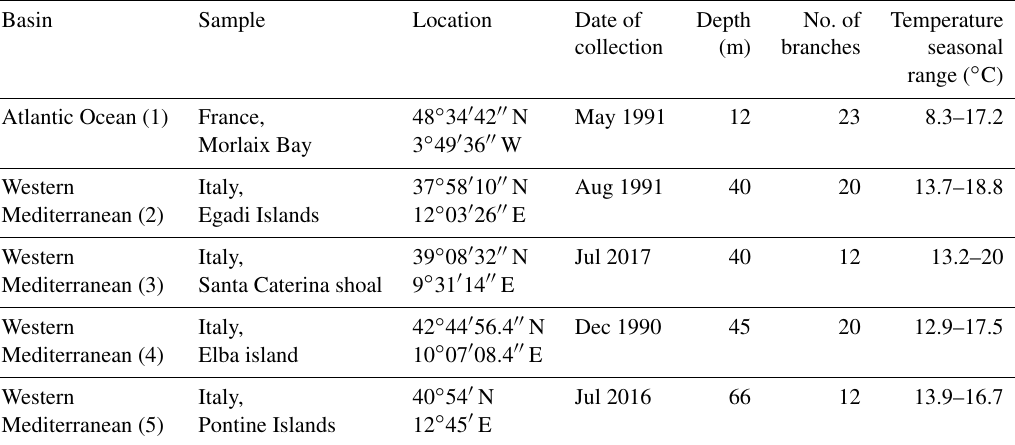
Table 1. Location, date of collection and depth of L. corallioides samples. In the “basin” column, numbers in brackets correspond to the point in Fig.